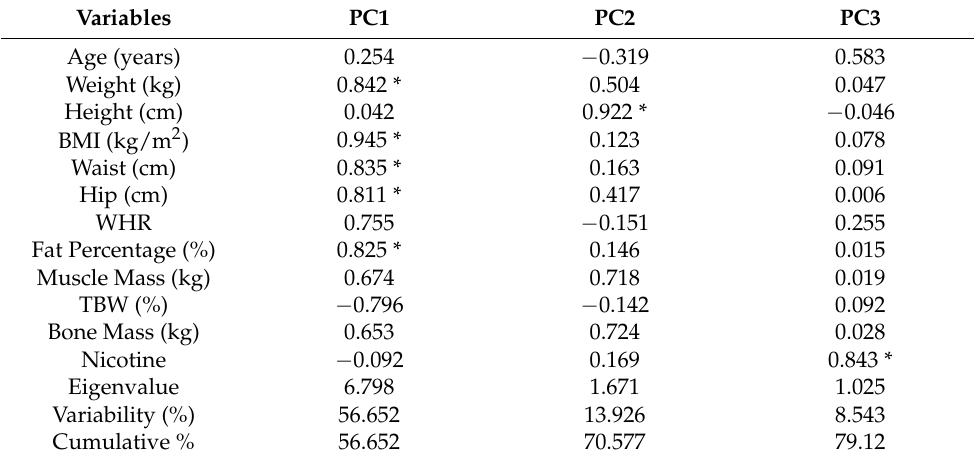
Table 2. Principal component analysis results after rotation.